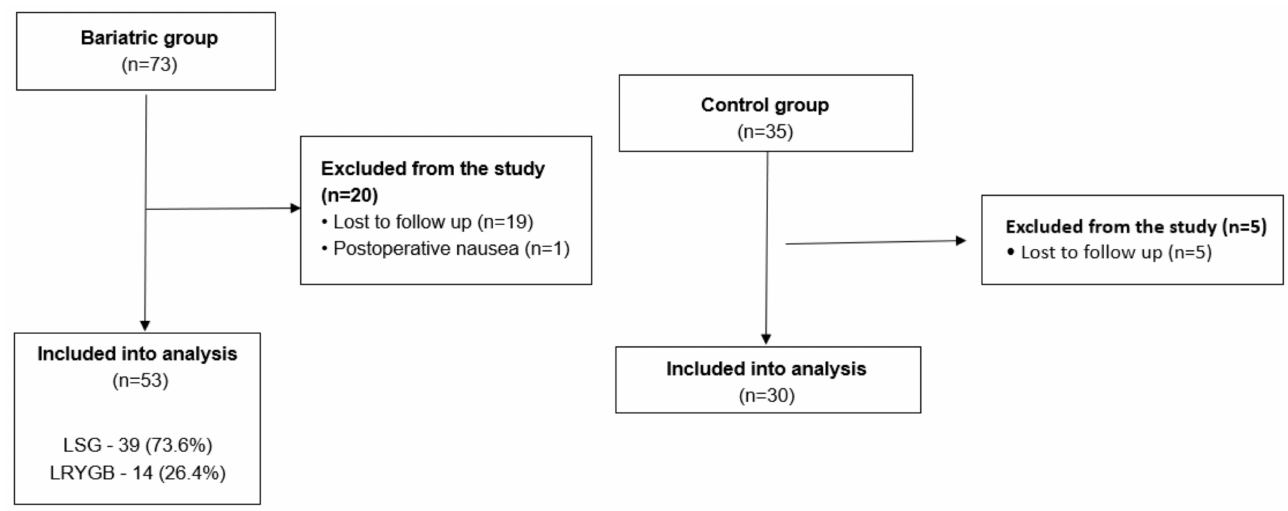
Figure 1. Patients flow through the